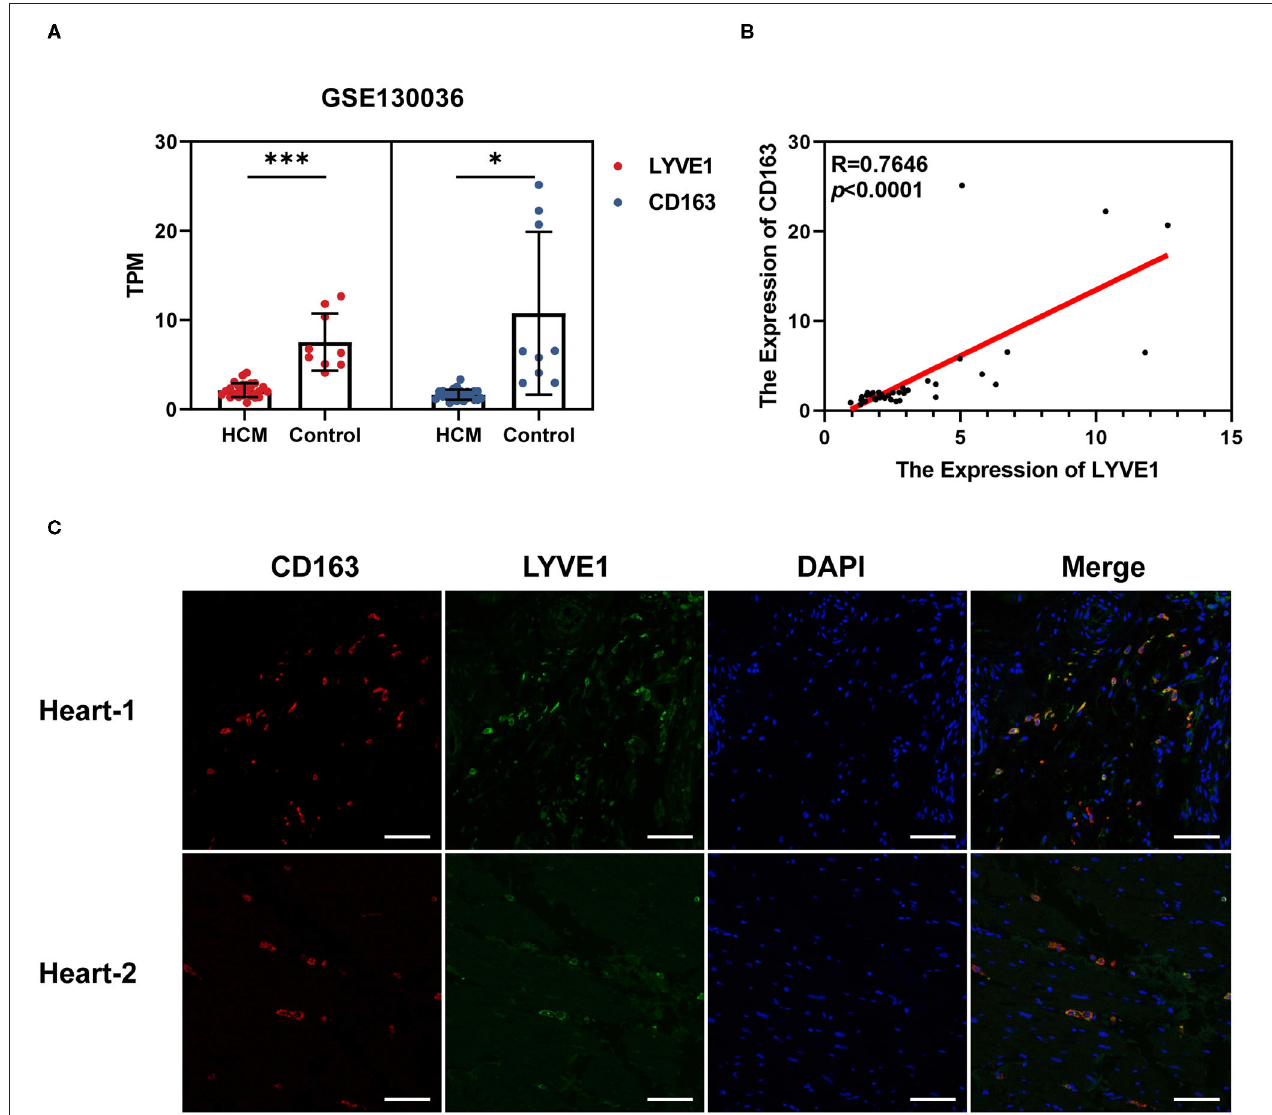
FIGURE 8 | Verification of crucial genes and immune cells in HCM. (A) Expression profiles of CD163 and LYVE1 in the verification dataset GSE130036. (B) Correlation plot of CD163 and LYVE1 in the verification dataset GSE130036. (C) Representative fluorescent staining images of heart-infiltrating CD163 + and LYVE1 + macrophages from cardiac tissues of two healthy donors (scale: 100 µ m). * p < 0.05,** p < 0.01,*** p <